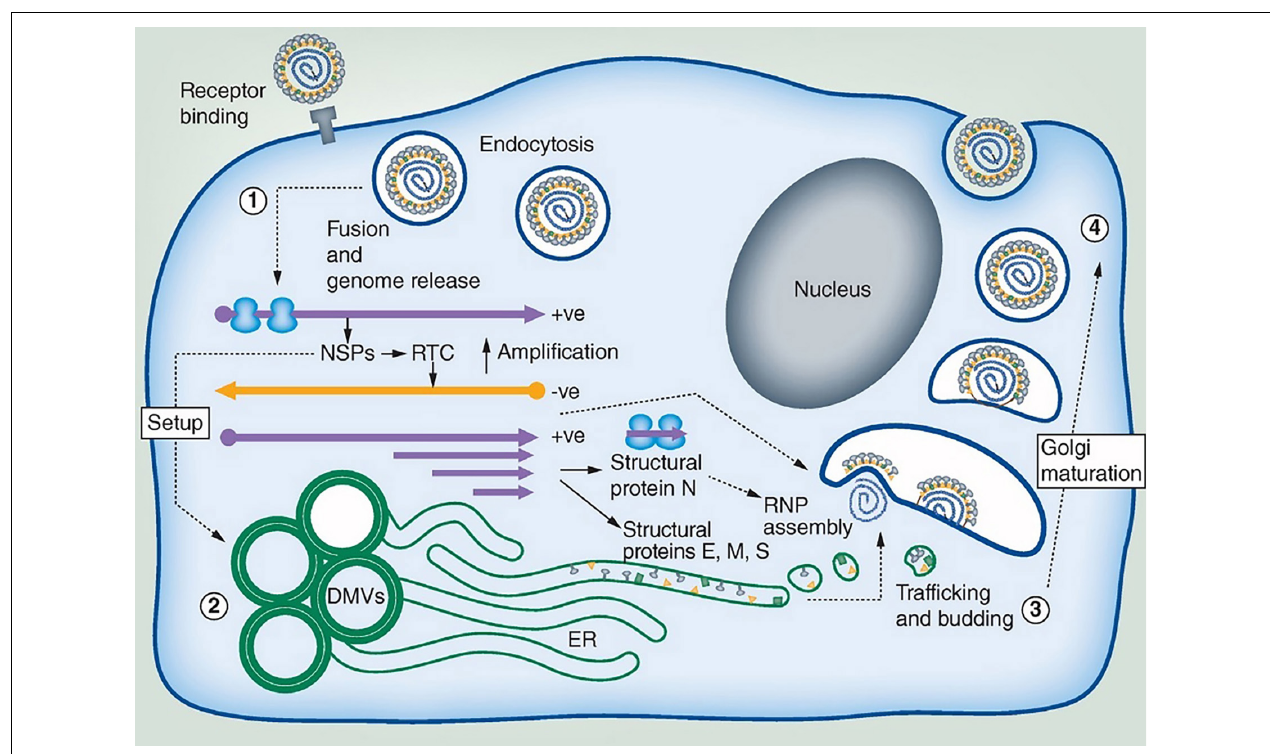
FIGURE 1 | Coronavirus replication cycle highlighting areas where membrane interaction takes place (ER, Endoplasmic reticulum; DMV, Double-membrane vesicles; ERGIC, Endoplasmic reticulum Golgi intermediate compartments). SARS-CoV-2 viral particles consist of four proteins: S (“Spike”), M (“Membrane”), E (“Envelope”), and N (“Nucleocapsid”). The pathway of membrane interactions involves: (1) Viral internalization through binding of the viral spike (S) protein to the membrane protein receptor as human angiotensin-converting enzyme 2 (ACE2). The coronavirus particle enters the host cell by receptor-mediated endocytosis followed by RNA release and translation into virus polyproteins, which encode for non-structural proteins (NSPs). (2) NSPs stimulate the production of DMV compartments and the formation of replication transcription complexes (RTC). Translation of the structural proteins (M, E, and S) occurs in the ER membrane organelles. (3) Coronavirus assembly occurs in the intermediate compartment between the ER and ERGIC. The protein cargos migrate through Golgi stacks resulting in new virus particles that are embedded in vesicles (4). These vesicles can further fuse with the plasma membrane and egress. Reprinted from Alsaadi and Jones (2019) with